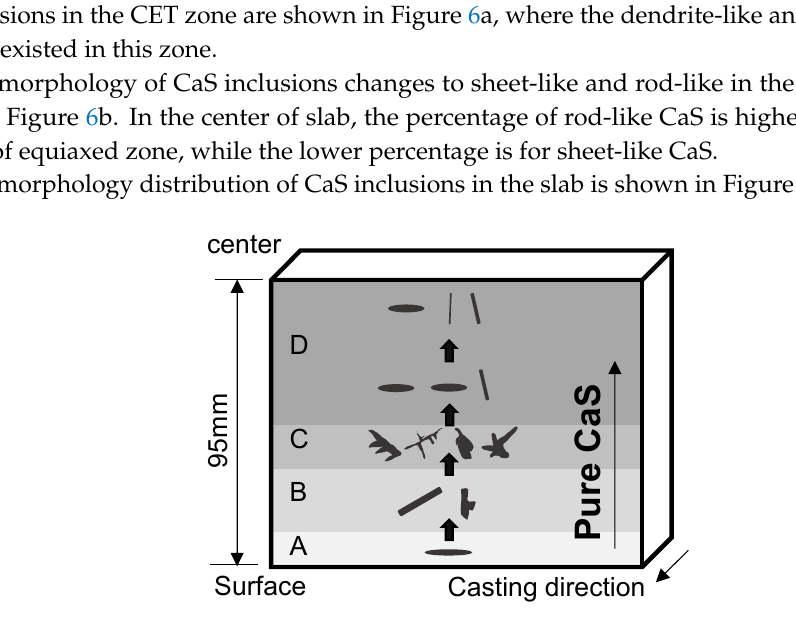
Figure 8. Schematic morphology distribution of CaS inclusions in slab (A is the chilled layer zone, B is columnar zone, C is CET zone, D is the equiaxed zone).